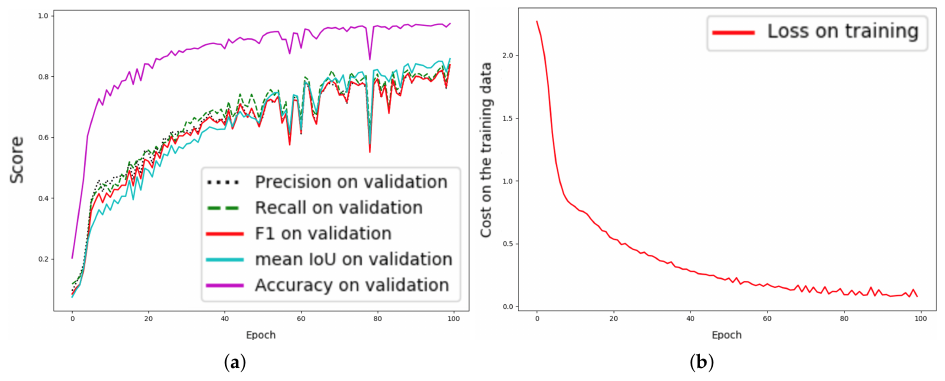
Figure 4. The learning curves of the baseline, “PRM-VS-TF”, on the Thailand Landsat-8 corpus; x refers to epochs and y refers to different measurements: ( a ) plot of model loss (cross-entropy) from training and validation corpora and ( b ) performance plot on the validation corpus.